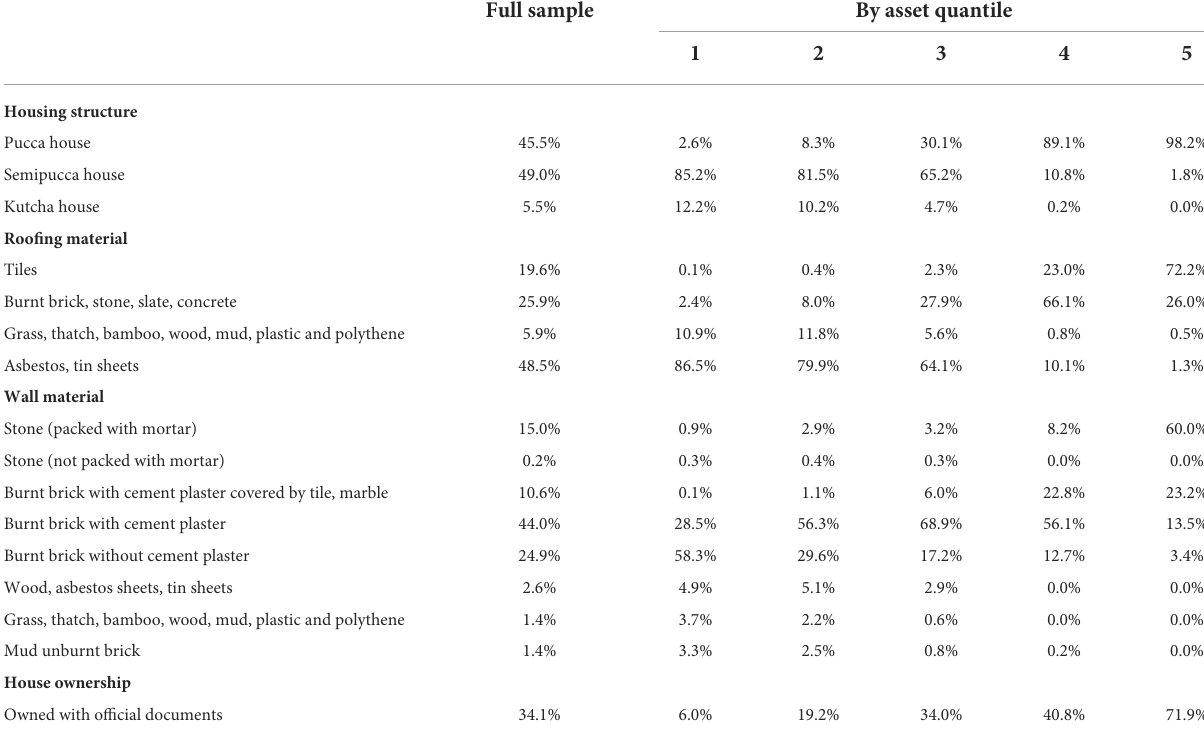
TABLE 4 Descriptive statistics